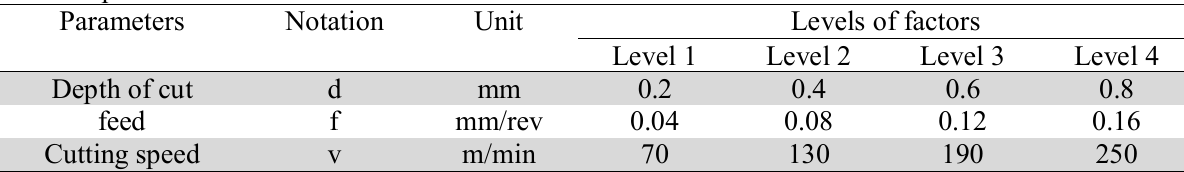
Process parameters and their levels